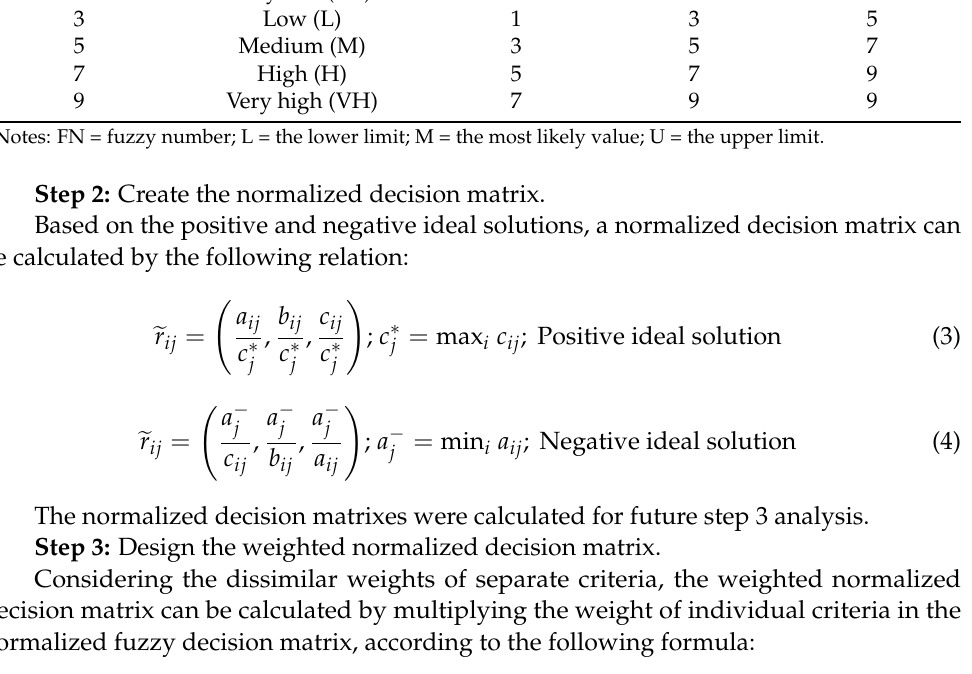
Table 2. Fuzzy scale description. FN 1 Linguistic Terms